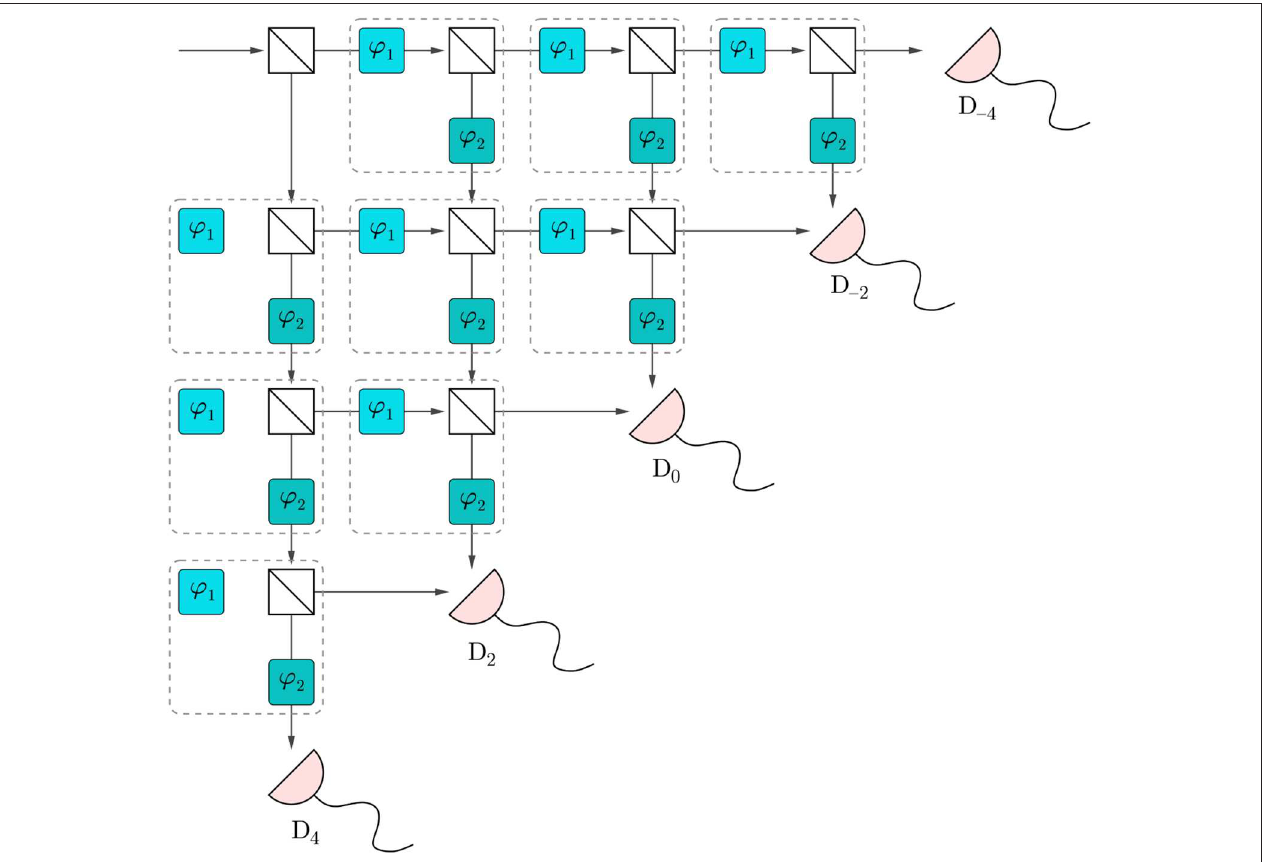
FIGURE 1 | Setup of a realization of a QW experiment [12] on a line of L 4 levels ( X 9 lattice sites). The solid (cyan) boxes represent phase shifters, shifting the = = phase of the wave by angles ϕ 1 or ϕ 2 , respectively. Open squares with a diagonal line represent 50:50 beam splitters. Half circles (pink) with a tail denote detectors at level 4, placed at lattice sites x 4, 2,0,2,4. Each group of three processing units, marked by a dashed border, causes the particle to jump left or = − −